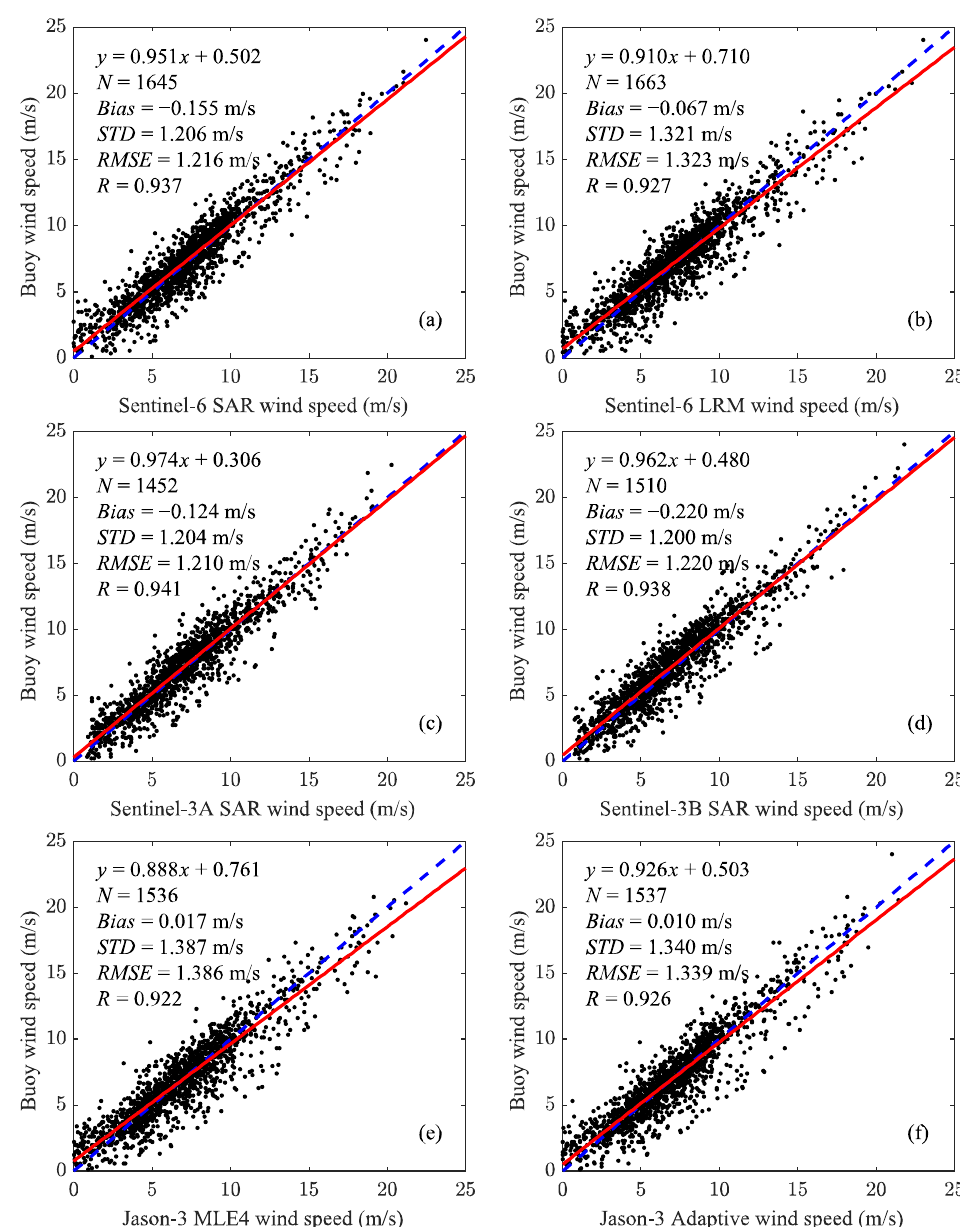
Figure 11. Scatterplots of ( a ) Sentinel-6 SARM, ( b ) Sentinel-6 LRM, ( c ) Sentinel-3A SARM, ( d ) Sen- tinel-3B SARM, ( e ) Jason-3 MLE4 and ( f ) Jason-3 adaptive wind speed measurements against the collocated NDBC buoys.